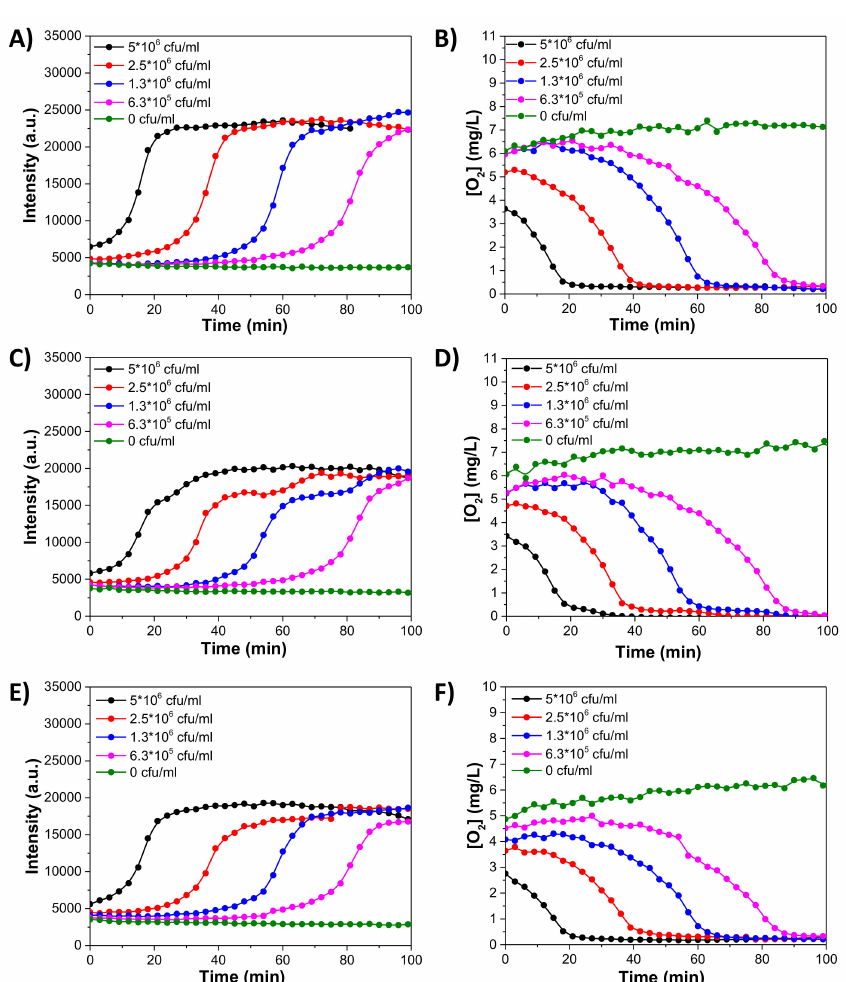
Figure 8. Oxygen consumption of E. coli JM109 under di ff erent densities monitored using micelles M1 – M3 . Concentration of PtTFPP was 3 µ g / mL in each micelle. ( A , C , E ): Representative emission changes at 650 nm with E. coli of M1 – M3 with oil sealing. ( B , D , F ): Corresponding dissolved oxygen concentration changes calculated from ( A , C , E ), respectively. ( A , B ) are for M1 ; ( C , D ) are for M2 ; ( E , F ) are for M3